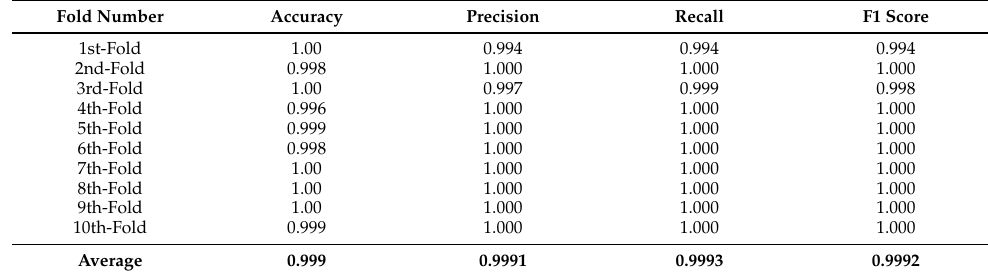
Table 10. Ten-fold cross-validation classification results using